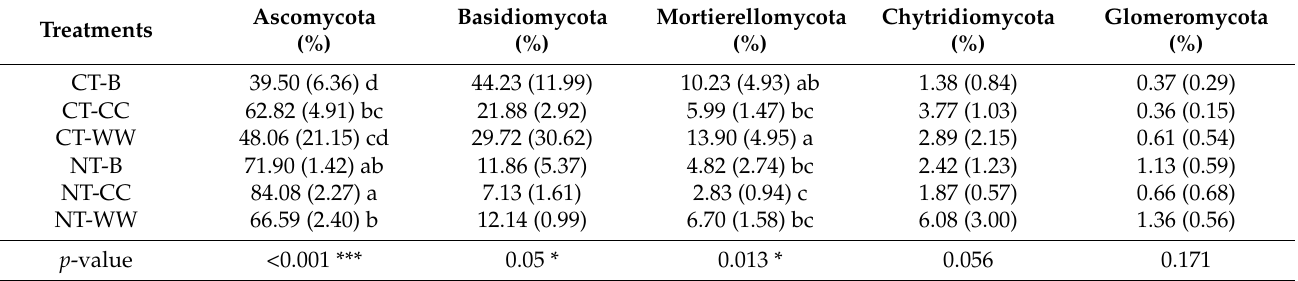
Table 2. Relative abundance of fungal phyla (obtained from the biom table) in the combination of crop rotation, tillage practice and winter cover management